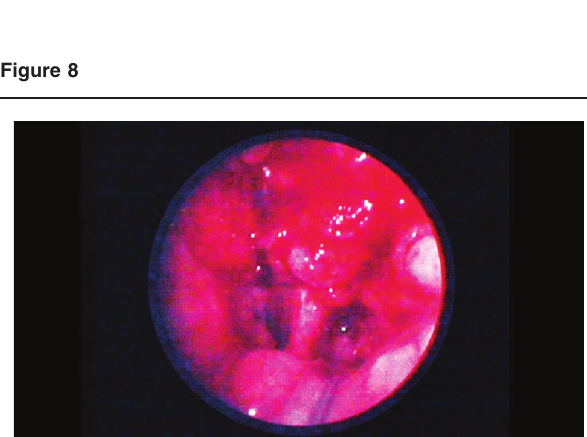
Comparison between the postoperative bleeding between both groups. Endoscopic view of adenoid bed